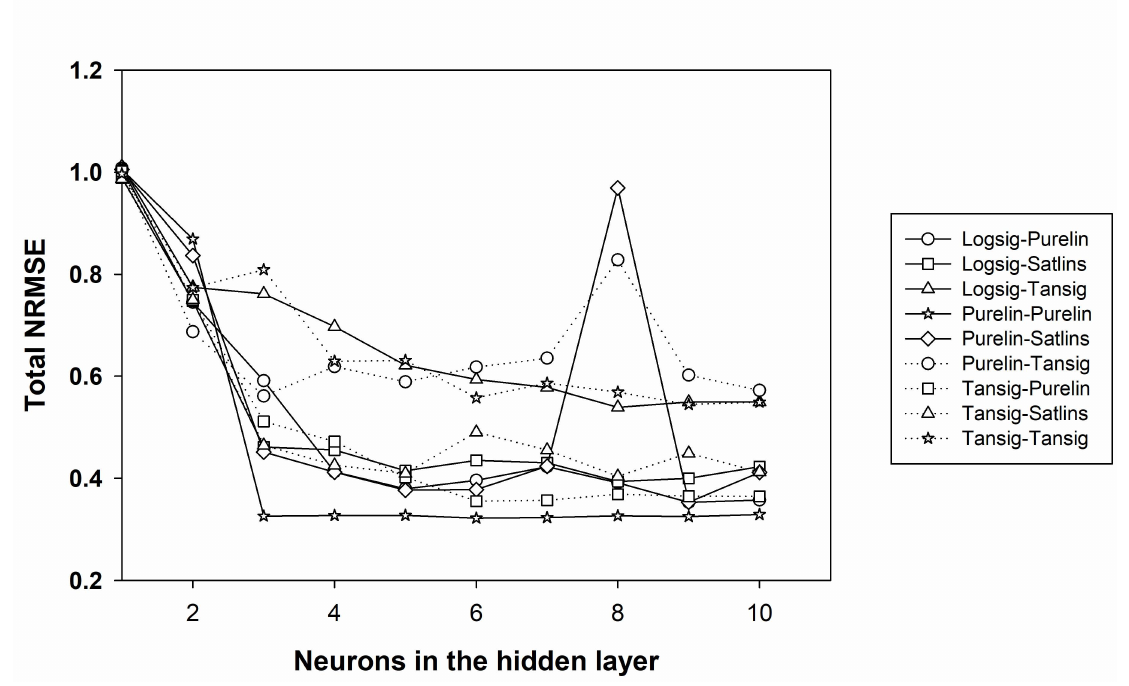
Figure 6. Normalized root mean square error (NRMSE) obtained for each transfer function combination and neurons in the hidden